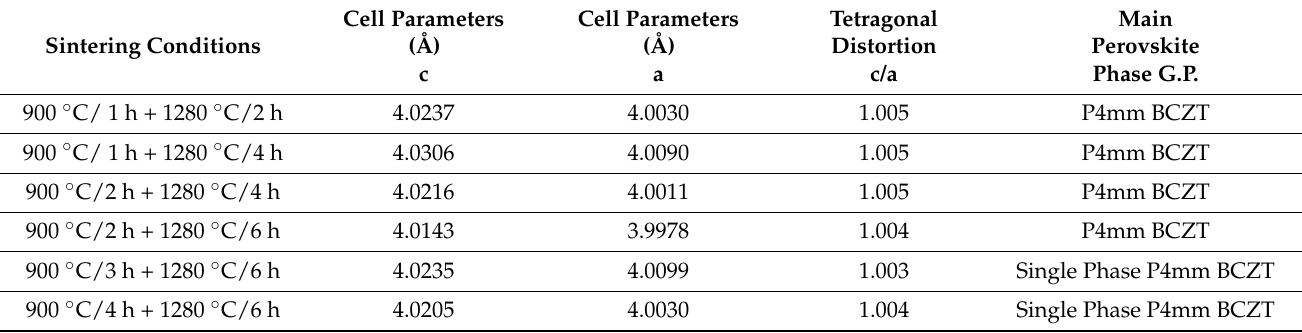
Table 1. Rietveld analysis of the sintered ceramics after synthesis at 700 °C and 2 h under variable time and temperature using a two-step sintering.